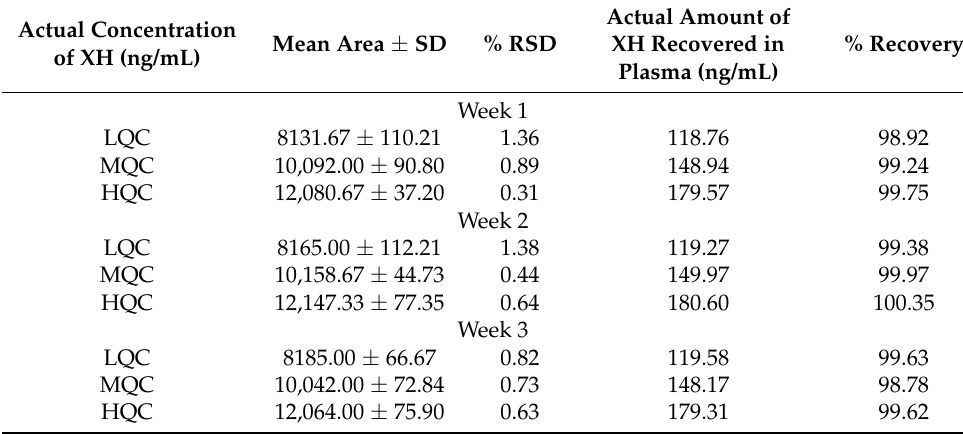
Table 7. Long term stability for plasma samples of